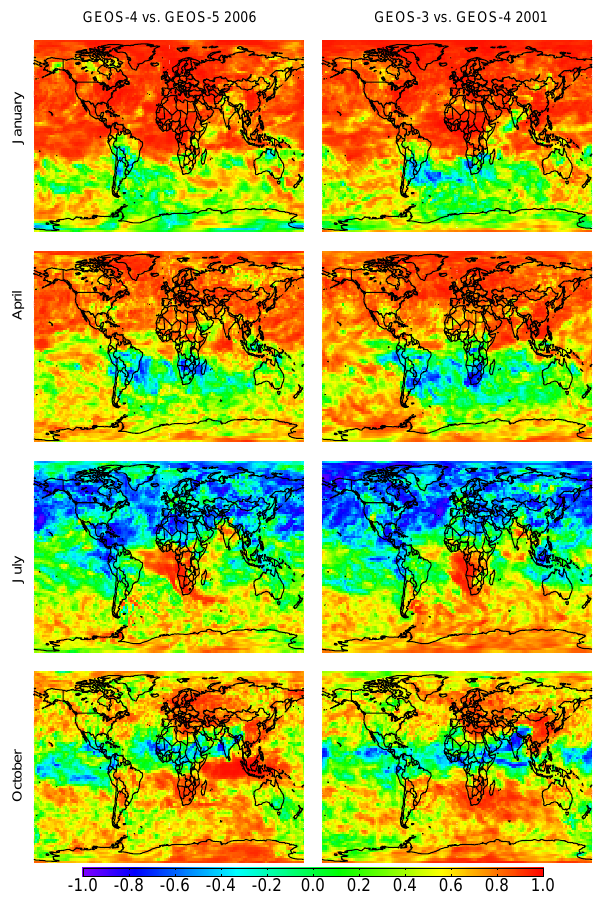
Fig. 2. Model error correlation coefficients between column CO 2 and column CO in different seasons calculated with the paired model method for GEOS-5 vs. GEOS-4 (2006) and GEOS-4 vs. GEOS-3 (2001) at 2 ◦ × 2.5 ◦ resolution. Both CO 2 and CO columns were sampled at 13:30 local time. No averaging kernels were ap-